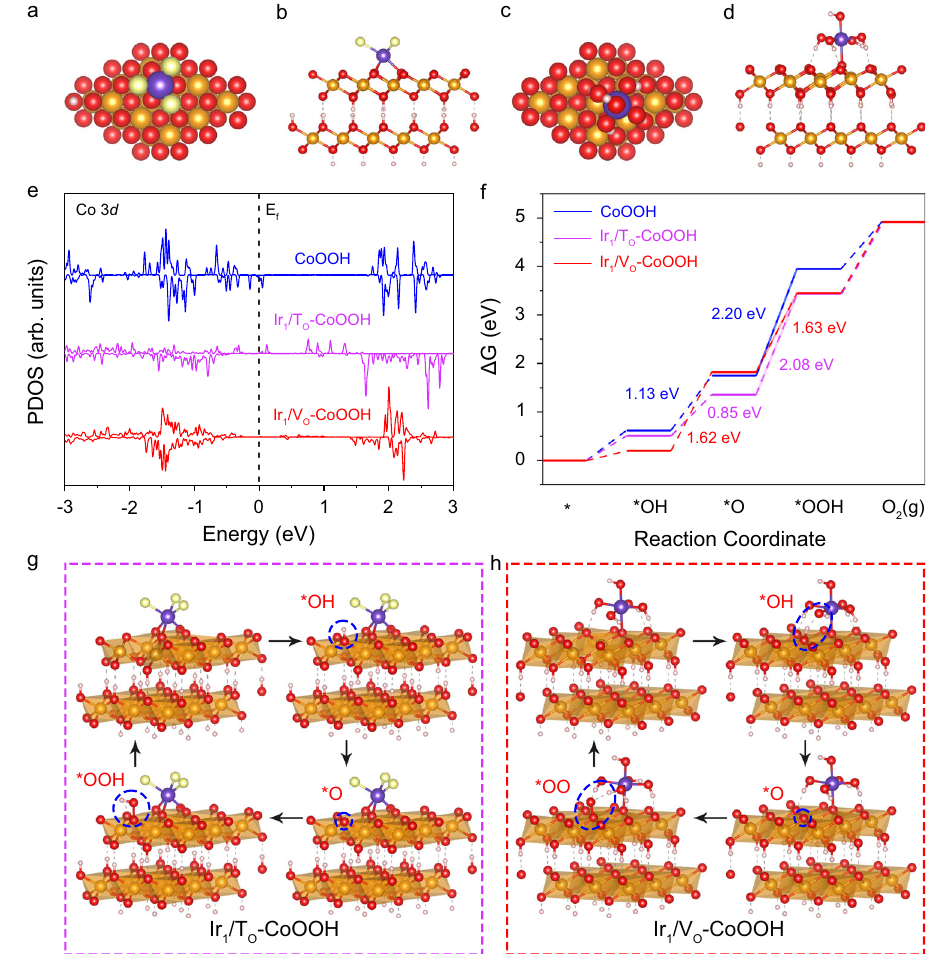
Fig. 5 OER mechanism studies for Ir 1 /T O – CoOOH and Ir 1 /V O – CoOOH. a , b Schematic structure model of Ir 1 /T O – CoOOH from top ( a ) and side ( b ) views. c , d Schematic atomic structure of Ir 1 /V O – CoOOH from top ( c ) and side ( d ) views. e Co 3 d projected density of states (PDOS) in CoOOH, Ir 1 /T O – CoOOH, and Ir 1 /V O – CoOOH. f , Free energy diagrams. g , h The schematic OER pathway for Ir 1 /T O – CoOOH ( g ) and Ir 1 /V O – CoOOH ( h ). The pink, red, yellow, orange, and purple spheres represent H, O, Cl, Co, and Ir atoms, respectively. The dashed grey line indicates the hydrogen bonding. The reaction intermediates are indicated by blue